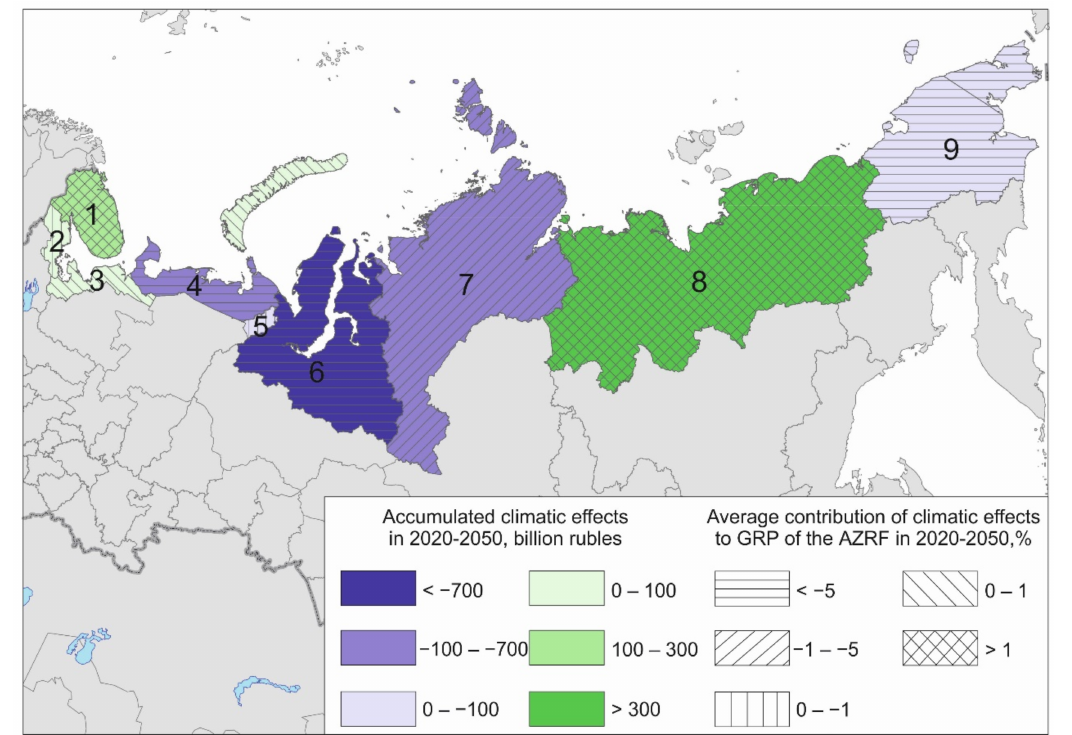
Figure 3. The results of the calculations of the economic effects of climate change on the economic development of the regions of the Russian Arctic for 2020–2050. The following regions are desig- nated by numbers in the figure: 1, Murmanskaya Oblast; 2, Karelia Republic; 3, Arkhangelskaya Oblast; 4, Nenets Autonomous Okrug; 5, Komi Republic; 6, Yamalo-Nenets Autonomous Okrug; 7, Krasnoyarskiy Krai; 8, Sakha Republic (Yakutia); 9, Chukotka Autonomous